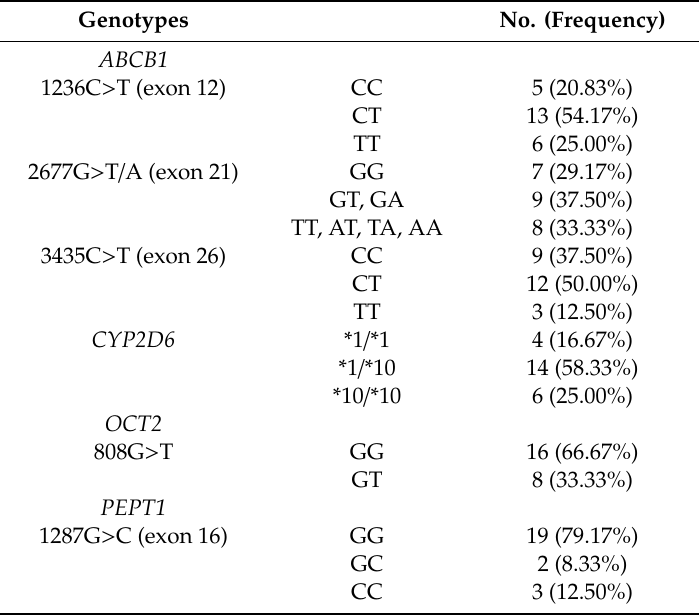
Table 2. Genetic information of the studied subjects ( n =